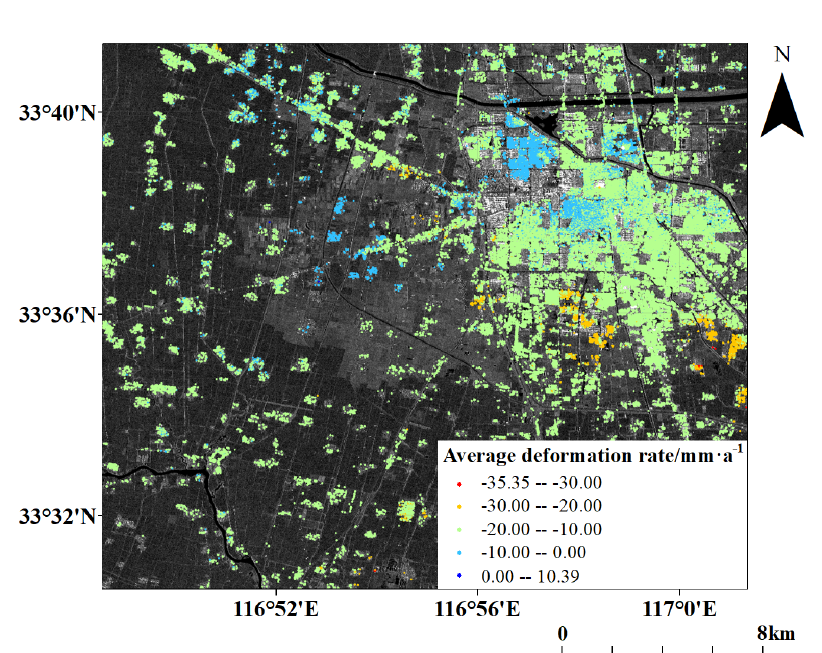
Figure 4. Deformation rates map in the study area from June 2017 to July 2020 based on the PS- InSAR